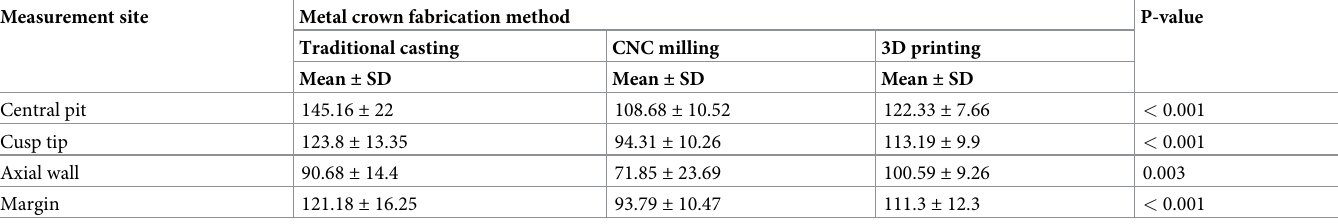
Table 1. Mean and standard deviation of the difference in each group at each measurement site (units: μ m). Measurement